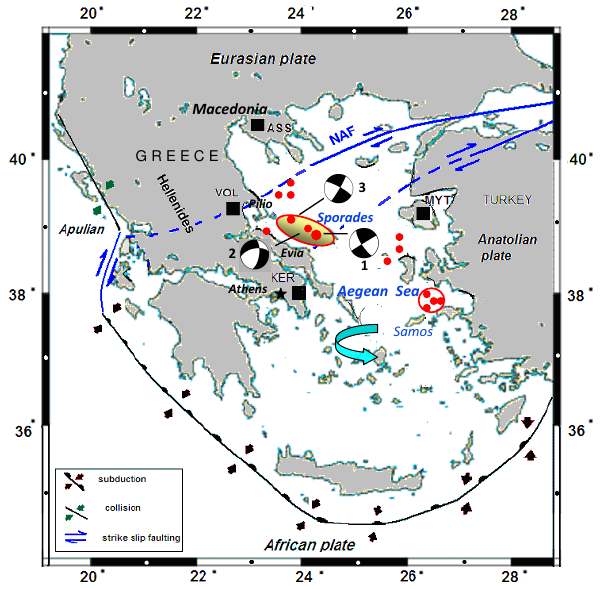
Fig. 1. Geotectonic map of Greece with all epicentres (red solid circles) of earthquakes of M w ≥ 5 occurred from 1 January 1995 to 20 October 2010 in the Aegean Sea between the latitudes (37– 40) ◦ N. CMT fault plane solutions are given only for the events lo- cated in the Sporades basin (shaded ellipse). A lower hemisphere projection is used with black and white quadrants (beach balls) for compression and dilatation, respectively. Numbers attached refer to the events in Table 1. The red open circle denotes the Samos cluster while black squares the positions of the VAN-SES stations sensitive to Aegean